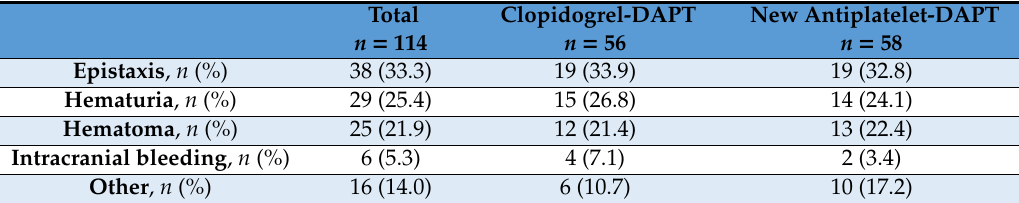
Table A1. Non-gastrointestinal bleeding events.